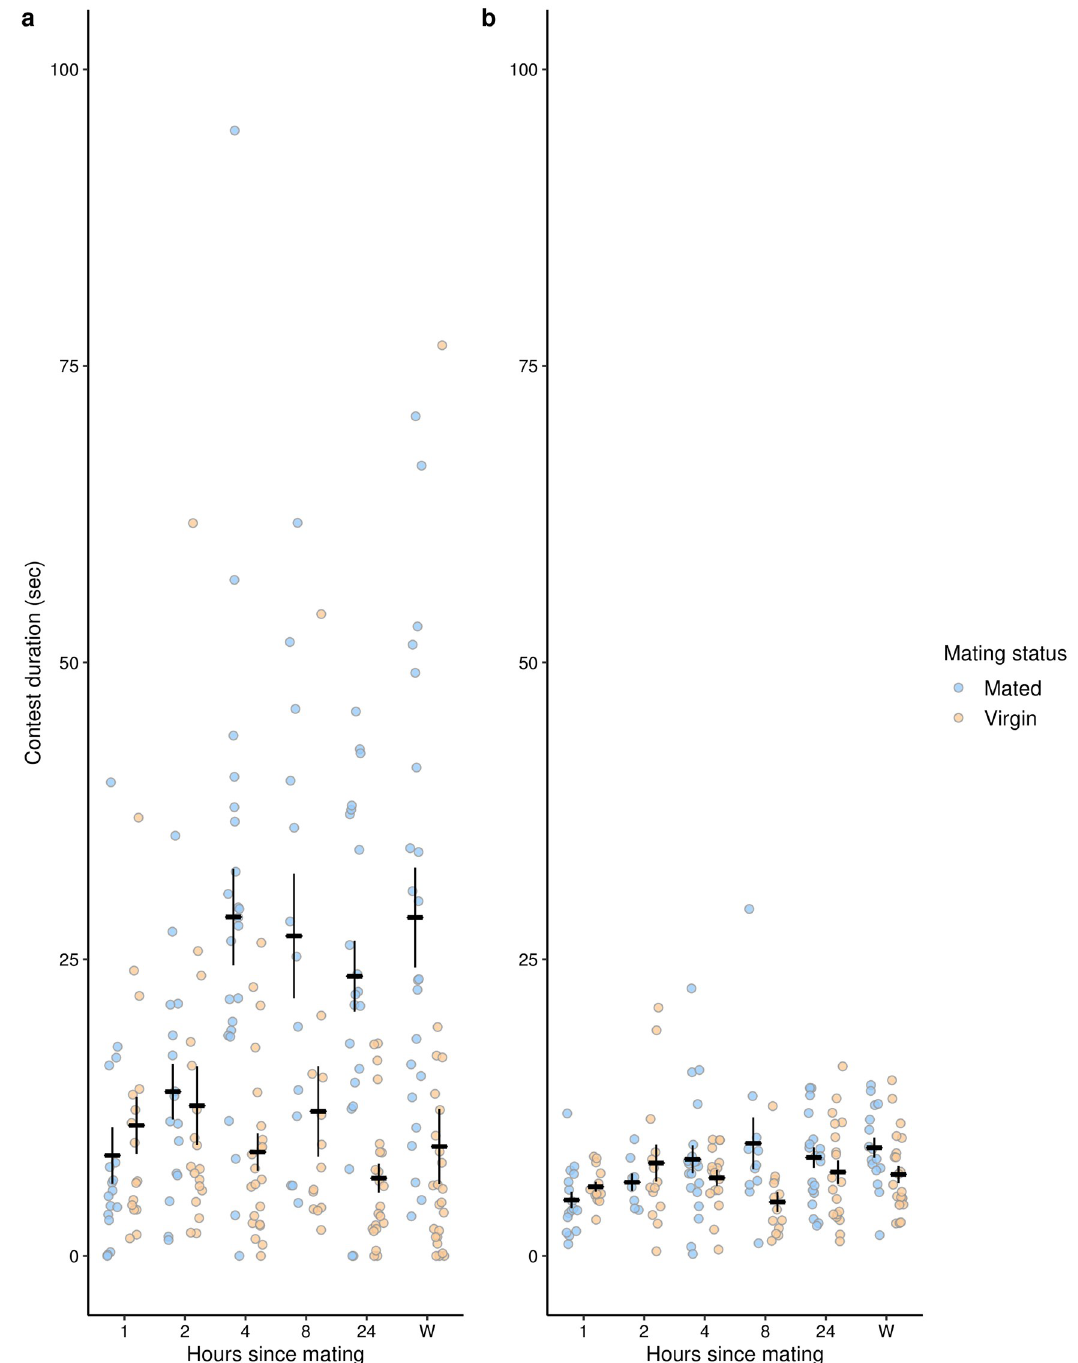
Fig 2. Mated females start to fight for longer than virgins around four hours after mating. a. Manual scoring of headbutt duration. b. Automated tracking and classification of headbutt duration. Blue points represent mated females, while yellow points represent virgin females. Each point represents the contest duration for one pair of females. The black bars represent the treatment means ± 1 standard error. The points in a and b represent the same videos scored manually (in a) and by the automated system (in b). We place them side by side here for comparison of the different